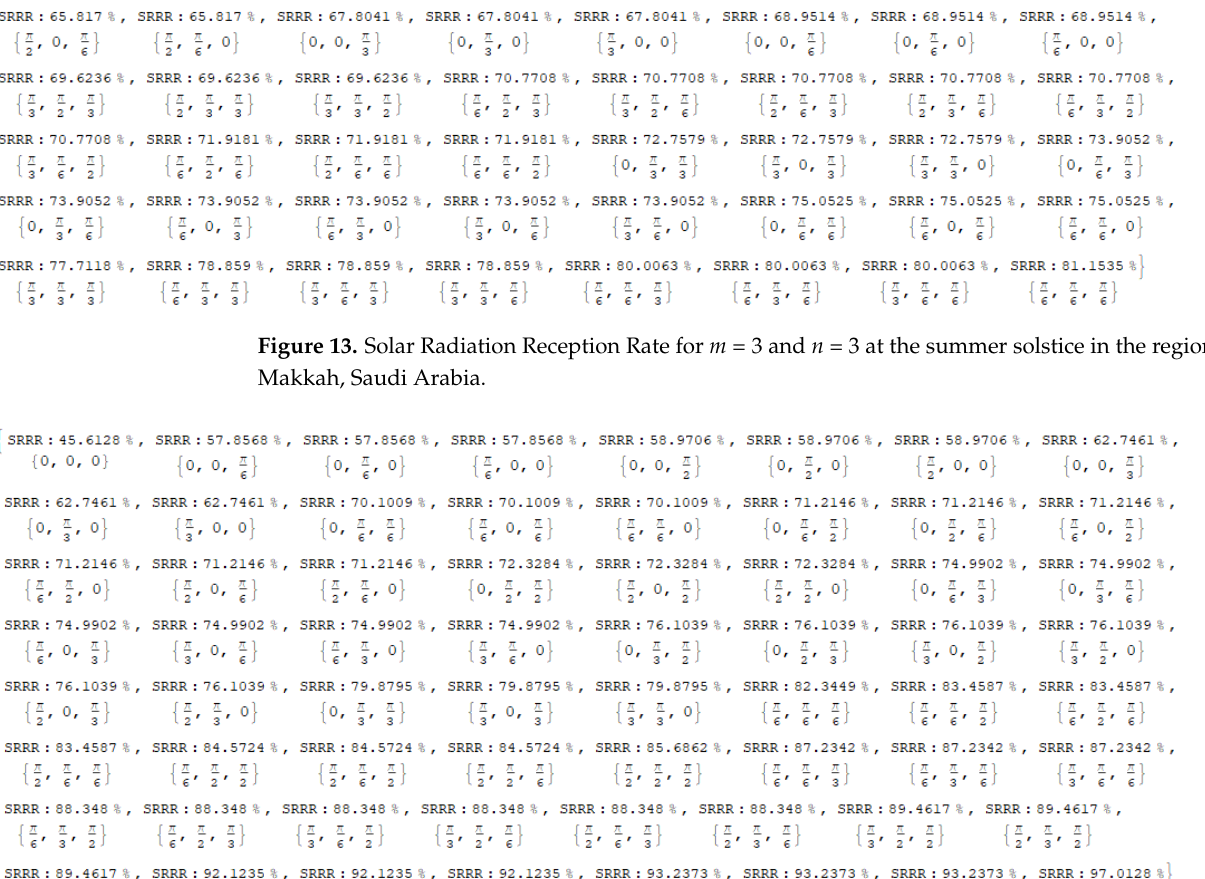
Figure 14. Solar Radiation Reception Rate for m = 3 and n = 3 at the winter solstice in the region of